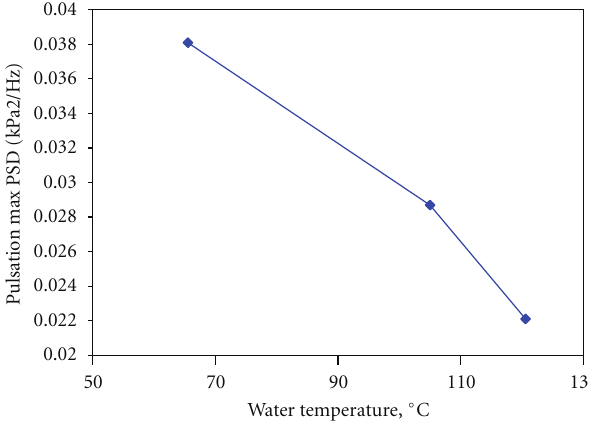
Figure 17: Comparison of pulsation spectra at 62,000 RPM.